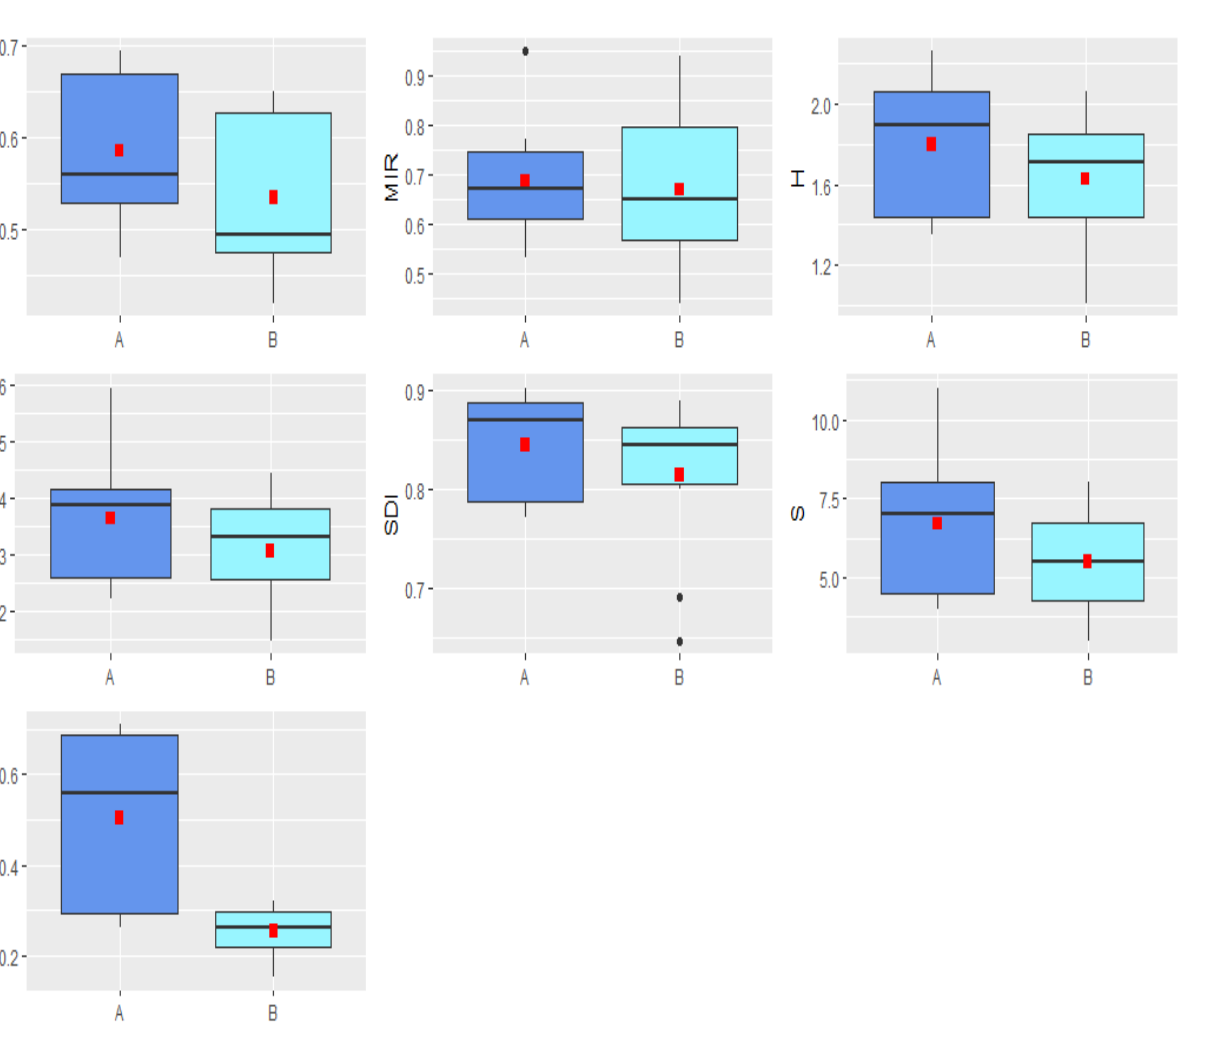
Figure 1. Box plots for the analyzed indicators. The box represents the first and third quartiles. The horizontal line across the central region of the box represents the median. A red square marks the mean value of the data. The whiskers are drawn to the most extreme observations located no more than 1.5 times the interquartile range away from the box. Any observation not included between the whiskers is considered an outlier and is plotted with a black dot. The whiskers indicate the minimum and maximum values when there are no outliers. A–habitat type A; B–habitat type B Table 1. Occurrence of plant species at habitats—number of sites (abbreviations used in figures). Taxa Habitat A Habitat B Total Cladophora sp. (Cla sp.) 1 0 Oedogonium sp. (Oed sp.) Spirogyra sp. (Spi sp.)